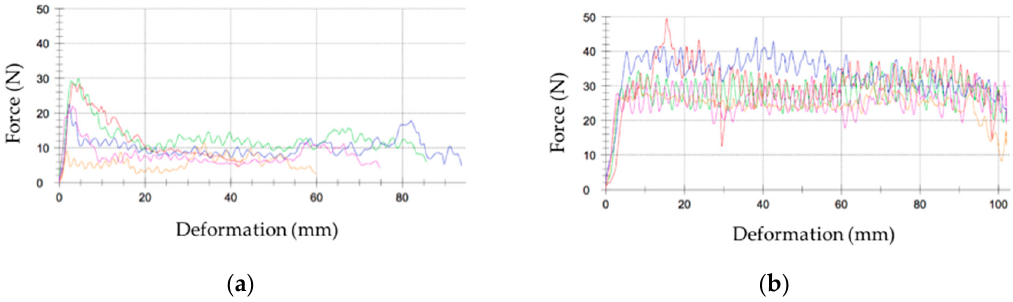
Figure 25. ( a ) Force of failure for interphase adhesion testing: LEP coating configuration with no-primer application, average value of 9.45 N and ( b ) LEP coating configuration with intermediate primer layer, average value of 29.31 N.